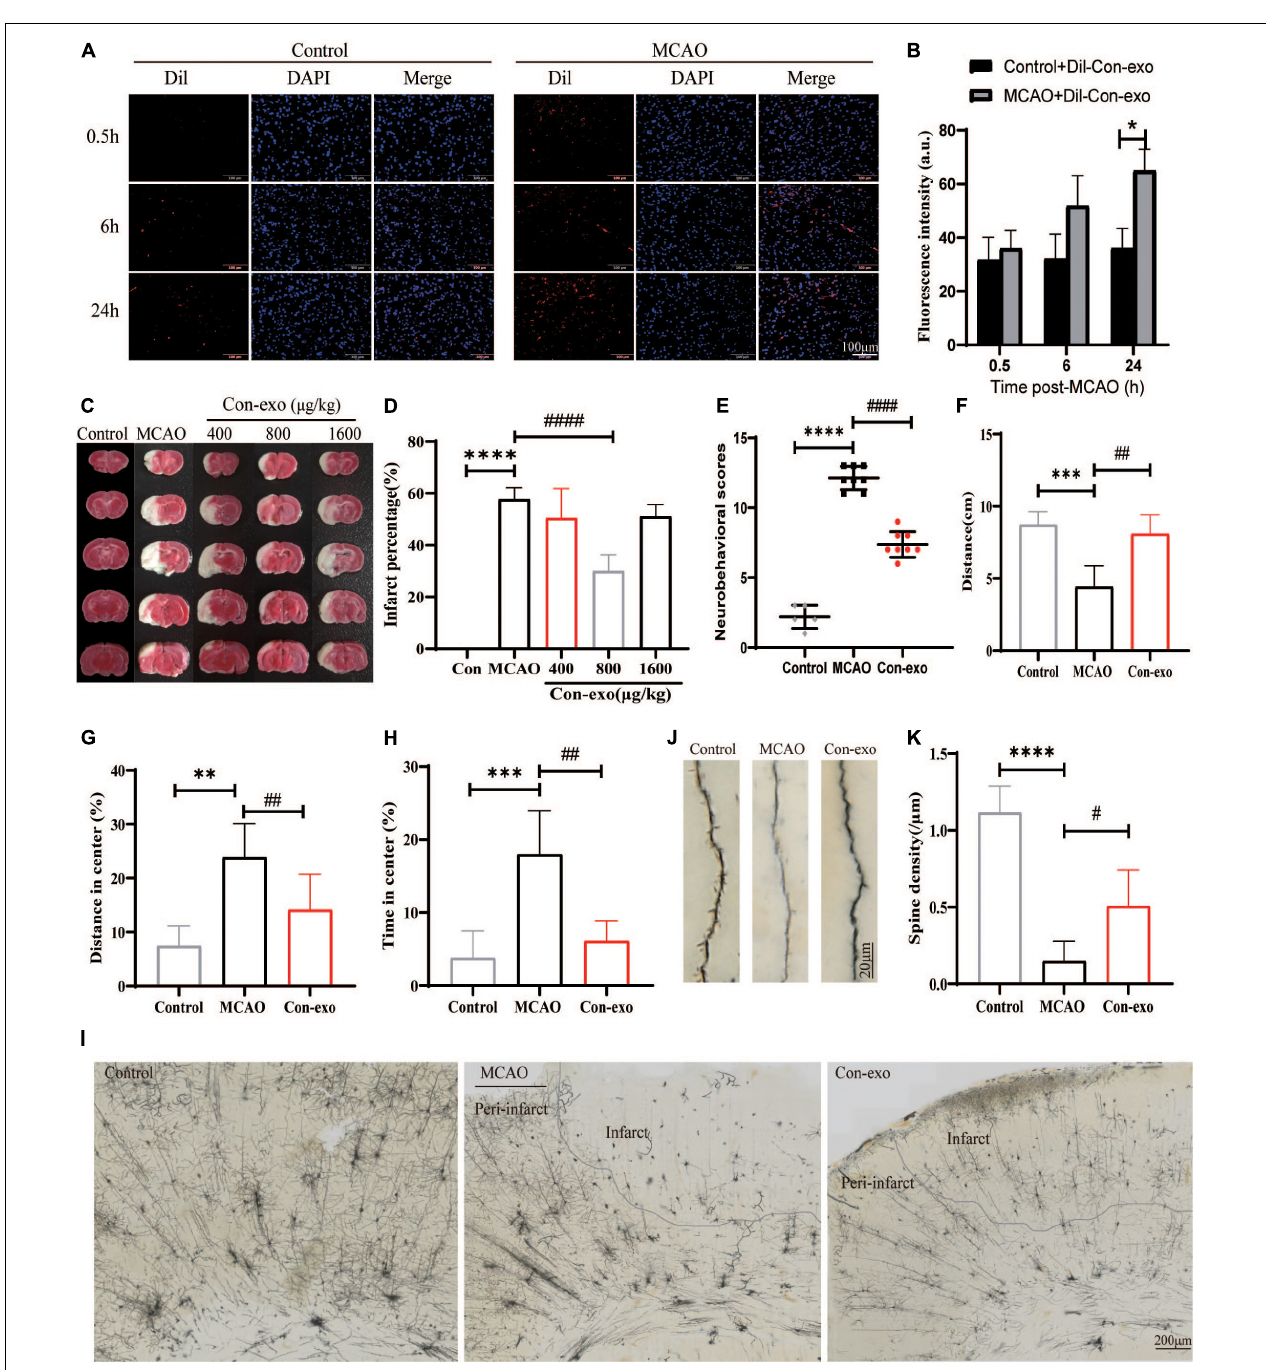
FIGURE 2 | Administration of serum exosomes protect against ischemic damage. (A,B) The representative images and statistical analysis of the penetration of Dil-labeled Con-exo accumulating in striatum of control and middle cerebral artery occlusion (MCAO) rats at 0.5, 6, and 24 h. The fluorescence intensity of Dil was counted from five different images of each group. (C) Representative 2,3,5-triphenyltetrazolium chloride (TTC)-stained images of phosphate-buffered saline (PBS)-treated (MCAO) and Con-exo (400, 800, and 1,600 µ g/kg)-treated brains from ischemic stroke mice (2 h MCAO, 24 h reperfusion). (D) Quantitative analysis of the percentage of infarct volume in TTC-stained brains ( n = 5). (E) Neurological deficit of ischemic rats was assessed by neurological severity score in the control, MCAO, and Con-exo groups ( n = 8). (F–H) Motor deficits of ischemic rats were assessed by open field test in the control, MCAO, and Con-exo groups ( n = 8). Total distance (F) , the percentage of distance in center (G) , and time (H) in center area were detected in each group. (I) Representative light microscopic images showing the pattern of Golgi-stained neurons in ipsilateral brains from control, MCAO, and Con-exo rats. (J) Representative images of neuronal dendrite and spine segments of each group as indicated. (K) Quantitative analysis of the effects of Con-exo on spine density in the peri-infarct cortex. * P < 0.05, ** P < 0.01, *** P < 0.001, **** P < 0.0001 vs. control; # P < 0.05, ## P < 0.01, ### P < 0.001, #### P < 0.0001 vs. MCAO.